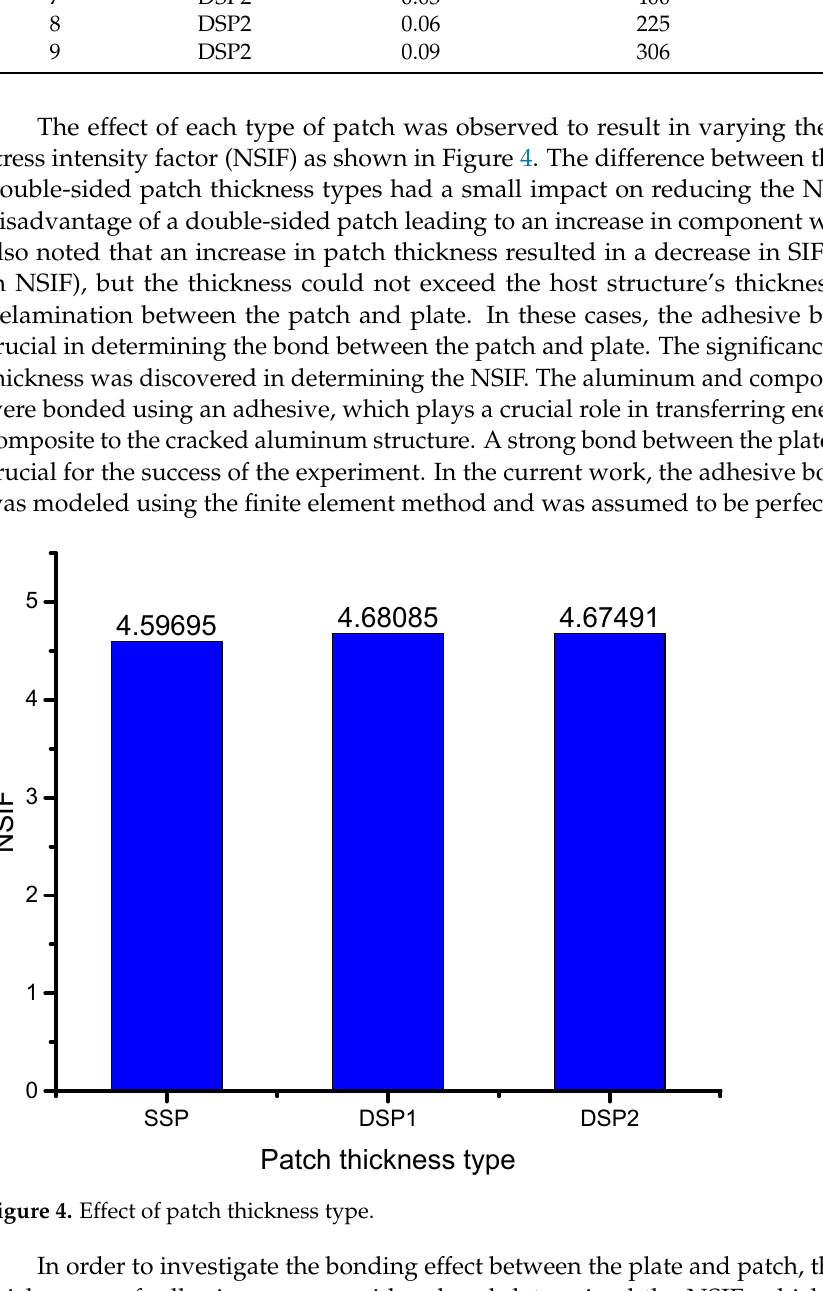
Figure 5. Effect of adhesive thickness. The third and crucial parameter of this study is the composite patch size, which has not been adequately addressed in the previous literature. To evaluate the effect of the patch size, three variations have been considered and used for optimization purposes. The ratio of the crack length to the plate width, which varies depending on the orientation of the crack length, determines the strength of the plate. For instance, if the crack length ex- ceeds 50% of the plate width, the crack propagation will be substantial when subjected to a load perpendicular to the crack length. Conversely, if the crack length is less than 50% of the plate width, the control of damage propagation is more effective. The patch dimen- sion also depends on the size of the crack or damaged area, with most studies indicating that the patch size should be twice the crack length. For example, if the crack length is 10